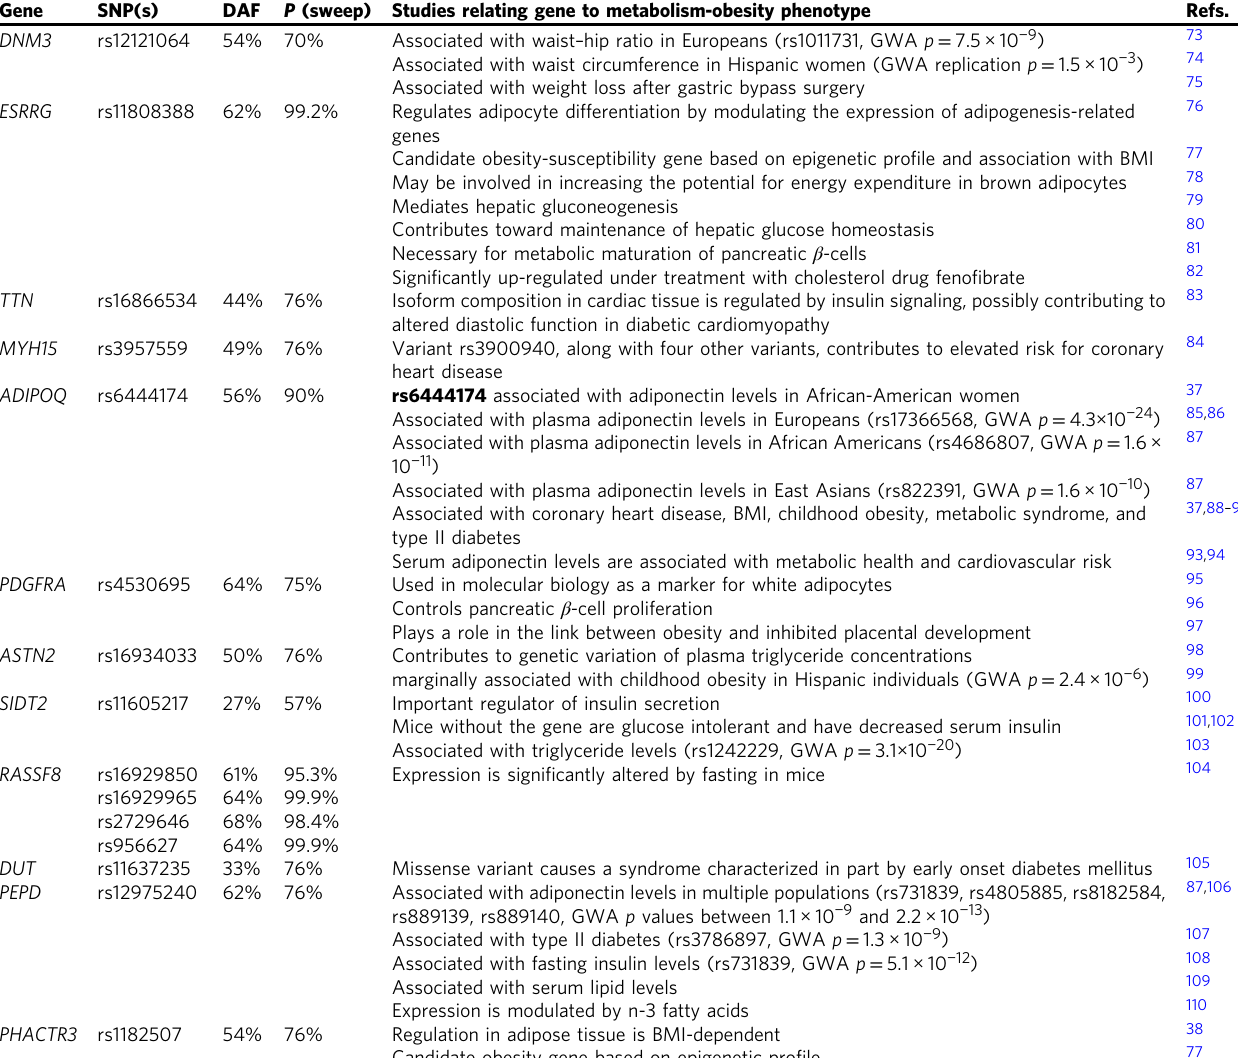
Table 1 Multiple published functional and association studies link genes identi fi ed by SWIF(r) to metabolism-related and obesity-related